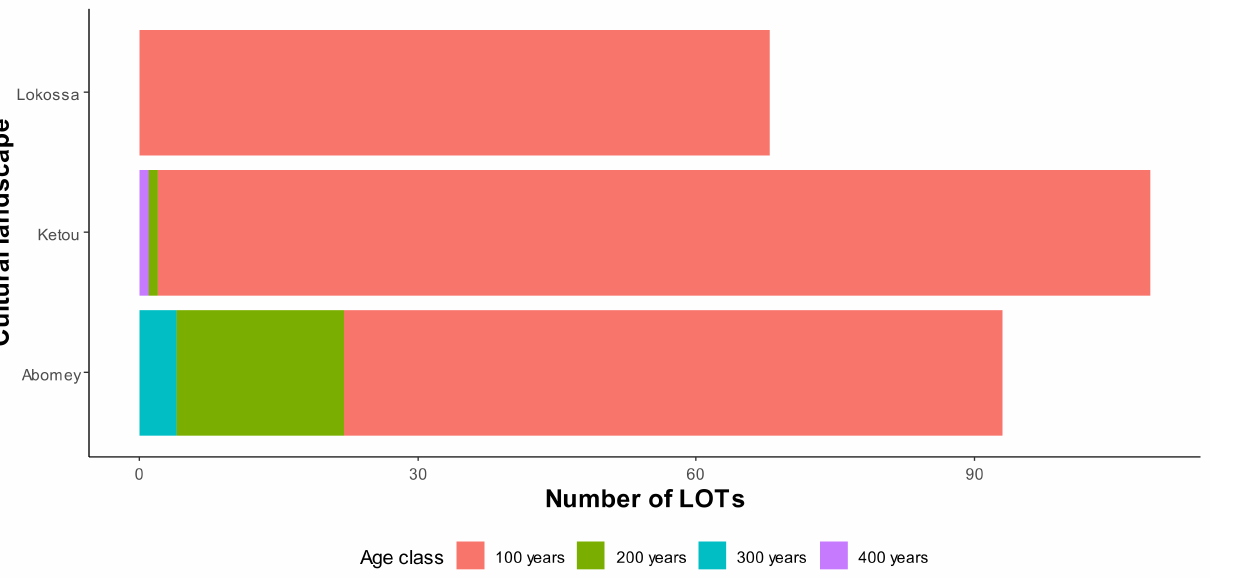
Figure 4. Variation in age class of LOTs in cultural